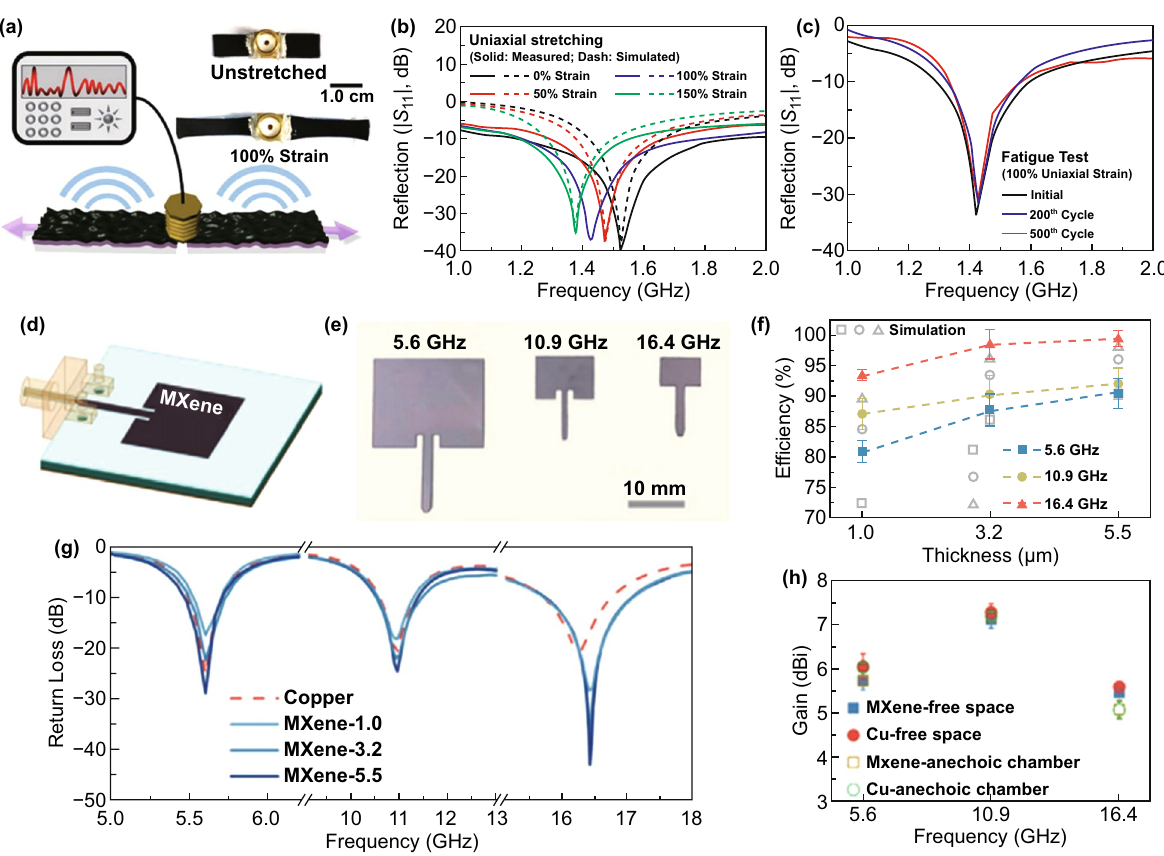
Fig. 3 a Schematic illustration and digital photographs (right) of an S‑MXene dipole antenna at different stretching states. b Measured and sim‑ ulated reflection | S 11 | and resonant frequencies of an S‑MXene antenna under different uniaxial strains. c Performance of stretchable S‑MXene antenna under 200‑ and 500‑cycle fatigue tests with uniaxial strain of up to 100%. Reproduced with permission from Ref. [50]. Copyright 2019, WILEY–VCH. d Schematic of a MXene microstrip patch antenna on dielectric substrate with SMA connector. e Digital image of as‑ fabricated MXene patch antennas at three target frequencies (5.6, 10.9, and 16.4 GHz), showing the geometry and size. f Return loss of MXene patch antennas of different thicknesses (1.0, 3.2, and 5.5 µm) at different target frequencies; copper patch antennas with the same geometry and dimensions were used as references. g Measured and simulated radiation efficiency of MXene patch antennas of different thicknesses at different frequencies. h The maximum gain of 5.5‑µm‑thick MXene antenna and a 35‑µm‑thick copper antenna at different frequencies measured in free space and an anechoic chamber, respectively. Reproduced with permission from Ref. [51]. Copyright 2020,